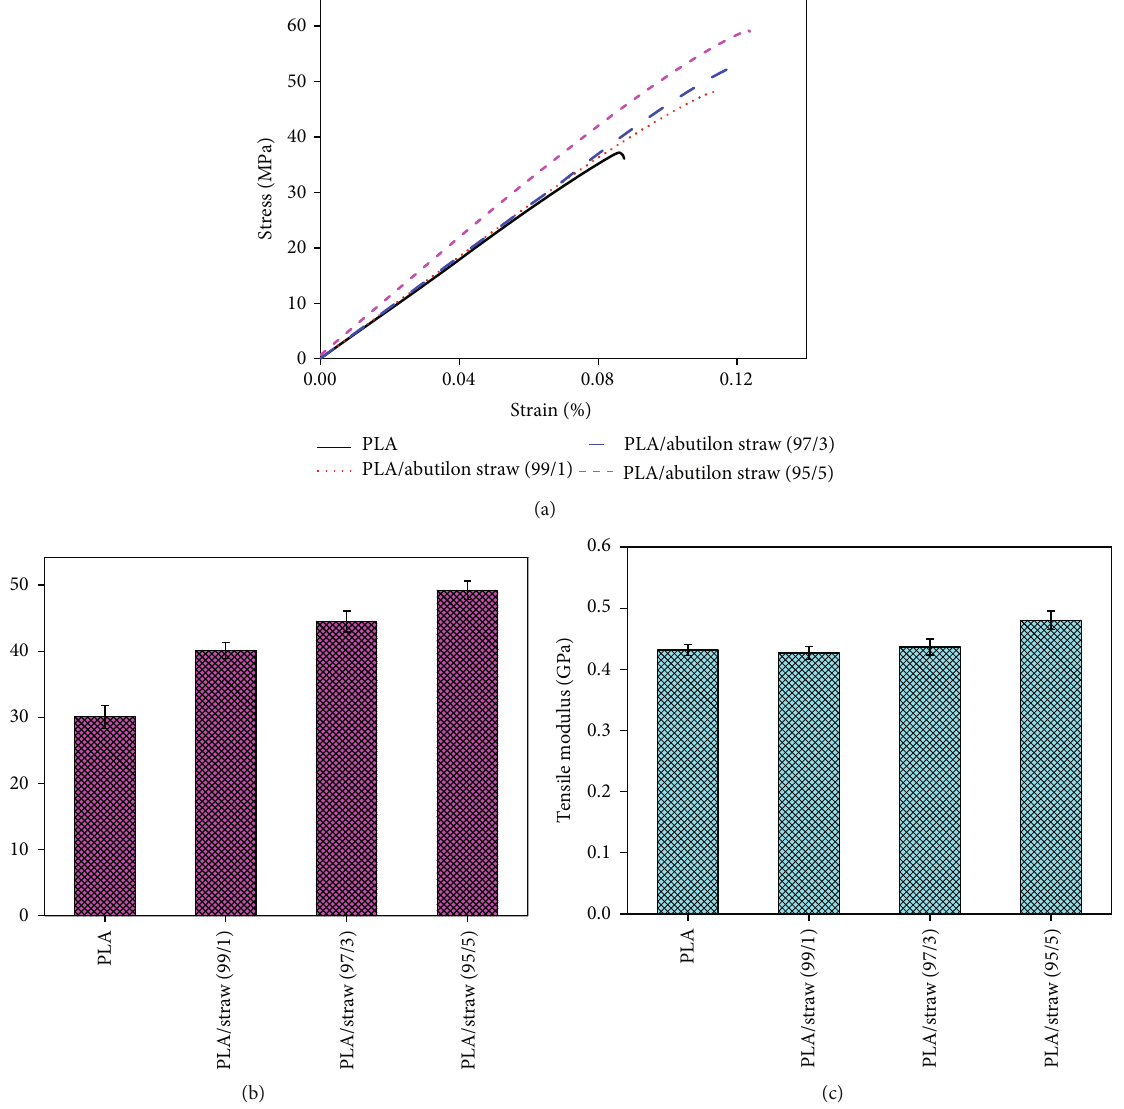
Figure 7: (a) Stress-strain curve, (b) tensile strength, and (c) tensile